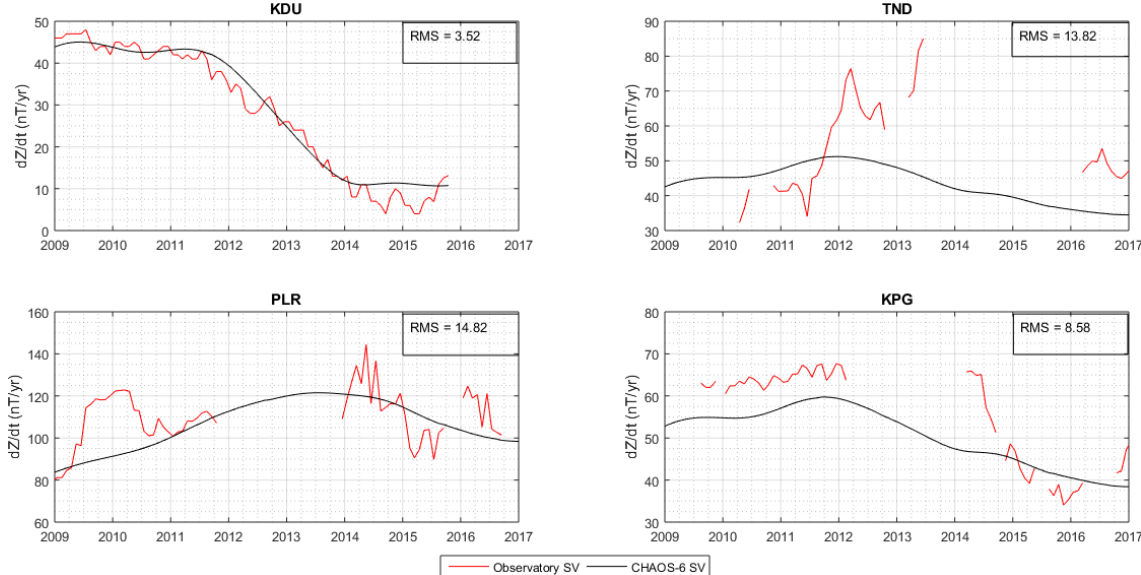
Figure 9. Secular variation comparison between Indonesian Observatory Data (KPG, PLR and TND) and CHAOS-6 model (Finlay et al., 2016). Kakadu (KDU) is included as a reference observatory near to Indonesia. The secular variation is computed using annual difference of monthly means. RMS values indicate the difference from CHAOS-6 in